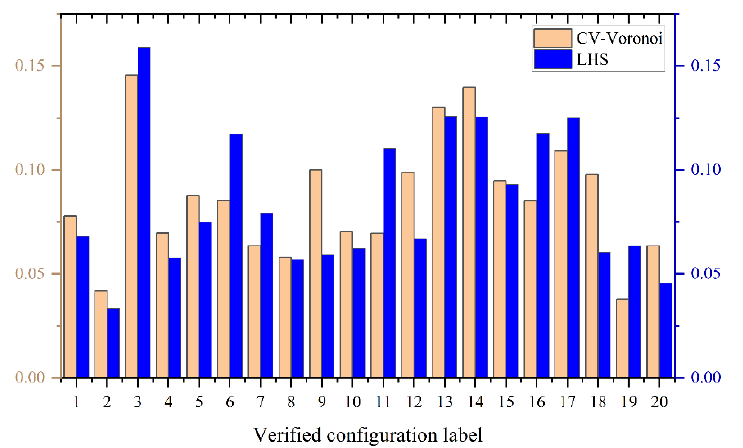
Figure 18. RMSE of verification configuration calculated by reduced-order model constructed with CV – Voronoi sequence sampling and LHS direct sampling.